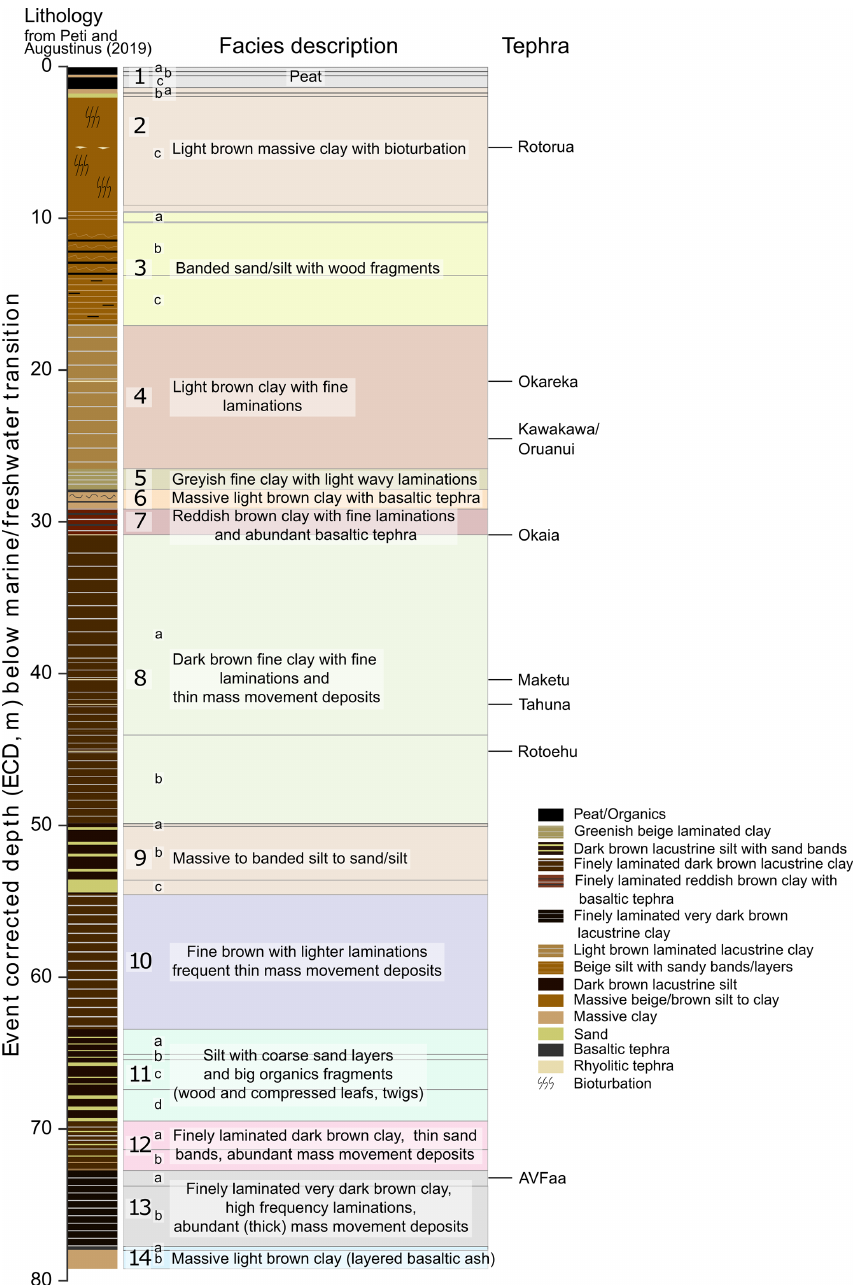
Figure 2. Simplified lithology and summarised facies unit description of the Orakei sediment sequence. After Peti and Augustinus (2019).